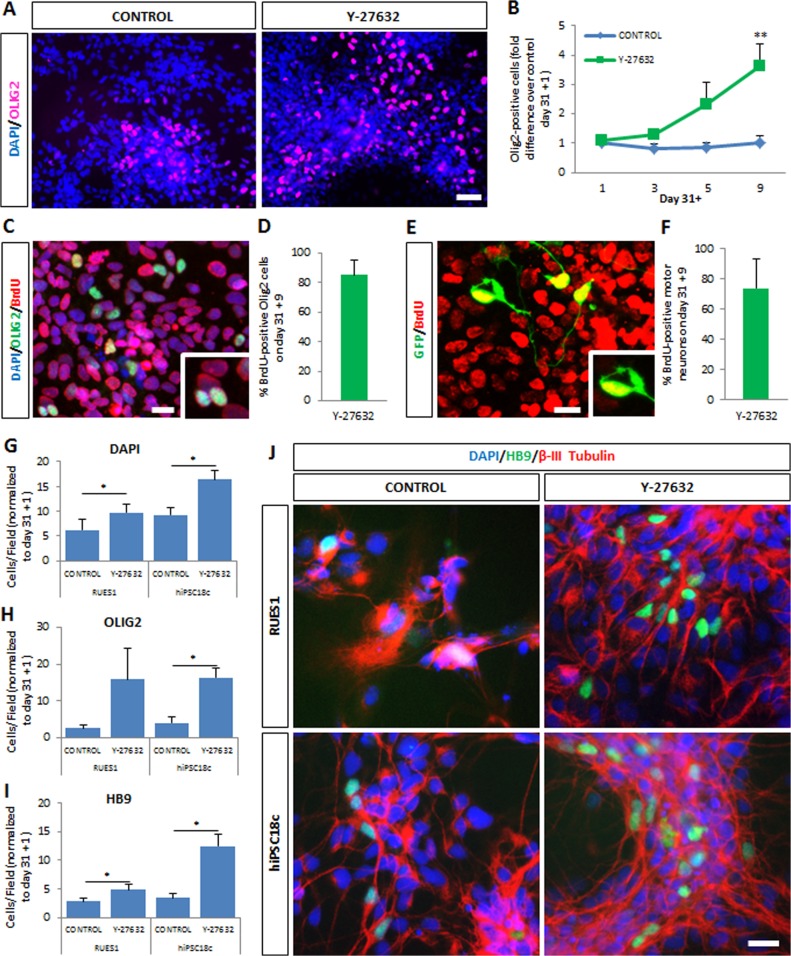
Y-27632 enhances proliferation of motor neuron progenitors in hESC- and hiPSC-derived motor neuron cultures.(A) Y-27632-supplemented cultures contain increased numbers of OLIG2-positive cells at day 31+9. Scale bar = 50 μm. (B) Time-dependent increase in numbers of OLIG2-expressing progenitors in the presence of Y-27632. Data normalized to control at day 31+1; mean ± s.e.m., n>5 (t-test, **p<0.01). (C) OLIG2 progenitors at day 31+9 stained for BrdU. Scale bar = 25 μm. (D) Percent of OLIG2 precursors that are BrdU-positive at day 31+9 (mean ± s.e.m., n = 4). (E) Hb9::GFP-expressing motor neurons at day 31+9 stained for BrdU. Scale bar = 25 μm. (F) Percent motor neurons that are BrdU-positive at day 31+9 (mean ± s.e.m., n = 4). (G) The total number of cells in culture is increased at day 31+9 following Y-27632 treatment of hESC RUES1 and hiPSC18c. Values are mean ± s.e.m., n≥3 (t-test, *p<0.05). (H) Numbers of OLIG2 precursors increase significantly at day 31+9 following Y-27632 treatment of hiPSC 18c. Values are mean ± s.e.m., n≥3 (t-test, *p<0.05). (I) Numbers of motor neurons identified by staining for endogenous HB9 increase significantly at day 31+9 following Y-27632 treatment of hESC RUES1 and hiPSC 18c. Values are mean ± s.e.m., n≥3 (t-test, *p<0.05). (J) Cultures from healthy control hESCs (RUES1) or hiPSCs (18c) immunostained for the motor neuron marker HB9 and the pan-neuronal marker β-III tubulin. Y-27632 increases the number of motor neurons in each case. Scale bar = 25 μm.